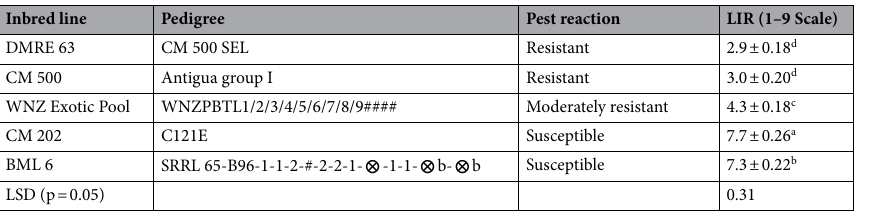
Table 1. Leaf Injury Rating of maize genotypes based on 1–9 scale by pink stem borer. Each value represents the mean ± SEm of four replications. Means within a column followed by different letters are significantly different (LSDTest p =